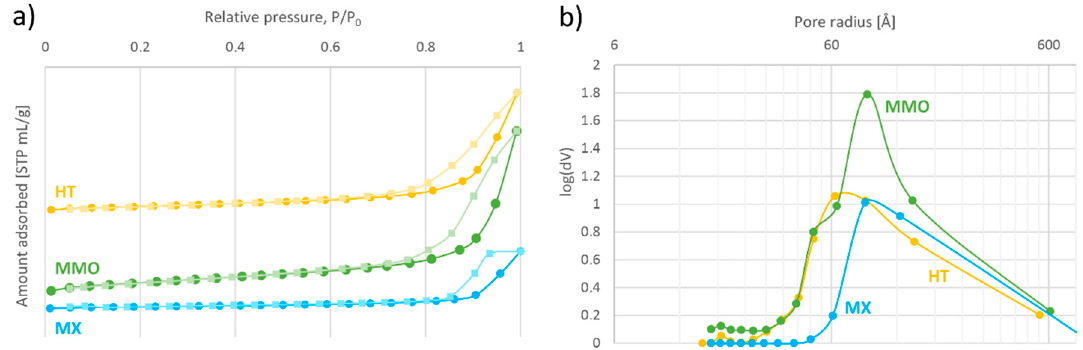
Figure 4. ( a ) Isotherms of N 2 adsorption–desorption, and ( b ) Barrett–Joyner–Halenda (BJH) pore size distributions of the prepared catalysts. Table 3. Results of the N 2 physisorption analysis of the prepared catalysts.